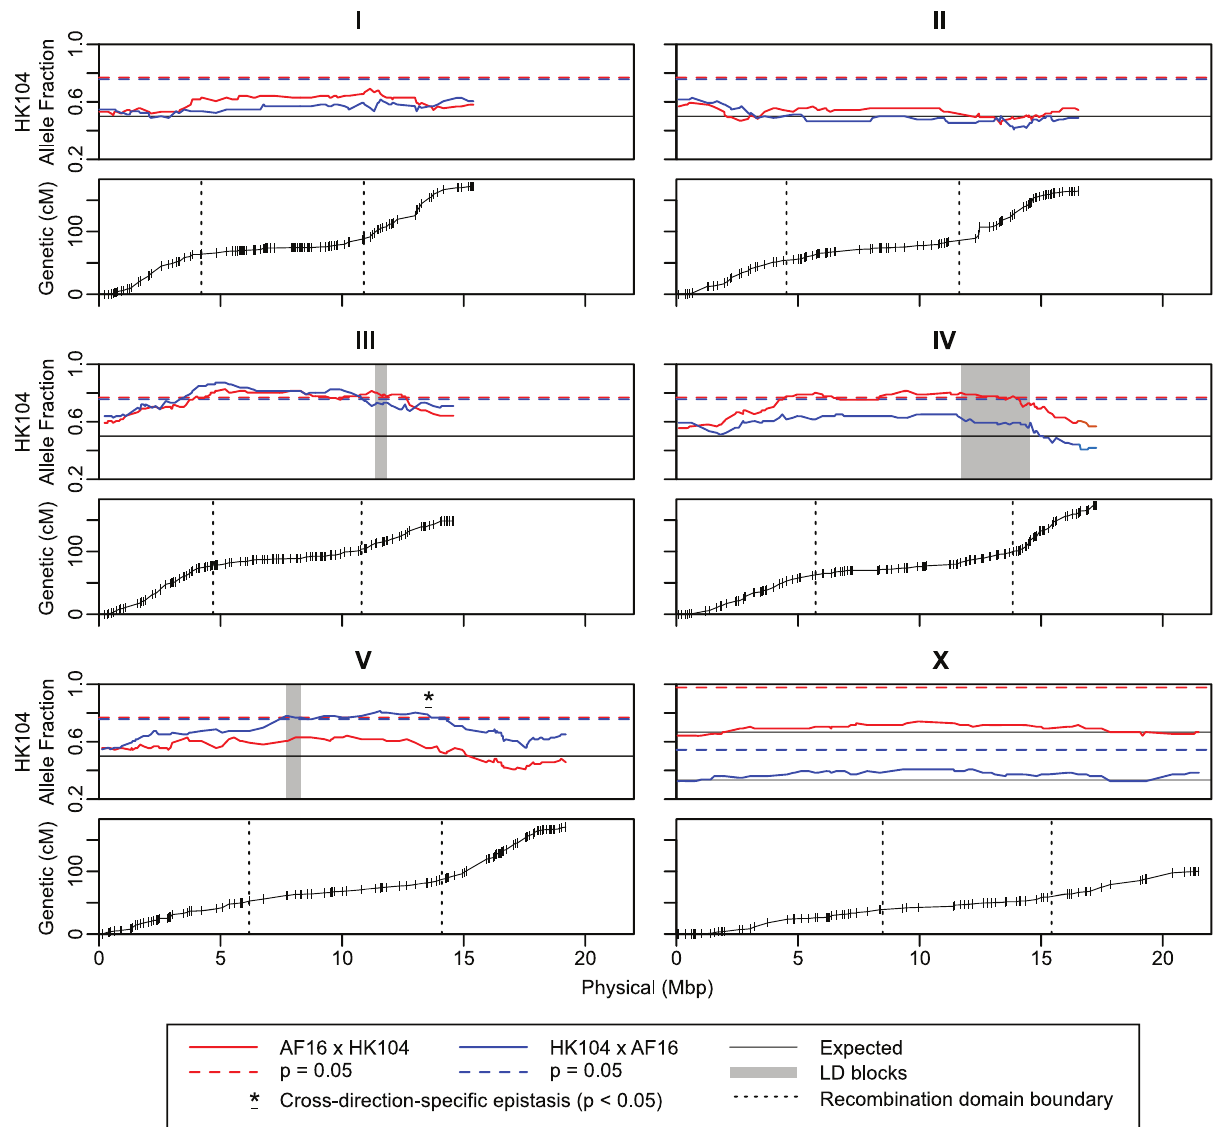
Figure 2. AI-RIL allele fraction and Marey plots. The upper panel for each of the six nuclear chromosomes depicts the fraction of AI-RIL fixed for the HK104 allele (y axis) at each genetic marker. The markers are ordered by physical position in the chromosome assembly (Mbp) on the x axis. For all chromosomes, the blue and red solid lines indicate the allele fraction at each marker for the HK104 6 AF16 and the AF16 6 HK104 cross directions, respectively. For autosomes, a single solid black horizontal line indicates the neutral-expected allele fraction of 0.5, and the dashed red and blue lines indicate the allele fraction at which deviation from the expected value becomes significant for each cross direction at p=0.05 (chi-square, Bonferroni- corrected by genome-wide effective number of tests). For ChrX, the distinct cross-specific expectations (solid black lines) and significance thresholds (dashed red and blue lines) are both given. Only HK104-biased thresholds are depicted, as the allele fraction values are never significantly AF16- biased. Three shaded areas show markers comprising interchromosomal LD blocks of high D 9 value (Figure 6). The asterisk and horizontal bar indicate the positions of three markers on ChrV whose allele fractions differ significantly from each other by cross direction. The lower panel for each chromosome depicts the relationship between physical position and genetic position of each marker; the y axis is genetic position in the linkage group in centimorgans (cM). Positions of genotyped SNP markers are shown as vertical lines. Vertical dotted lines depict the positions of the arm- center recombination rate domain boundaries estimated by linear regression. recombination rate as a function of physical position (Marey maps; [59], Figure 2). This reveals the presence on each chromosome of small tip domains and larger central domains that host less recombination compared to the chromosome ‘‘arm’’ domains (Caenorhabditis chromosomes are holocentric [60]). As previously found in C. elegans and C. briggsae , the X chromosome domain boundaries are qualitatively less evident than those of the autosomes [15,38].